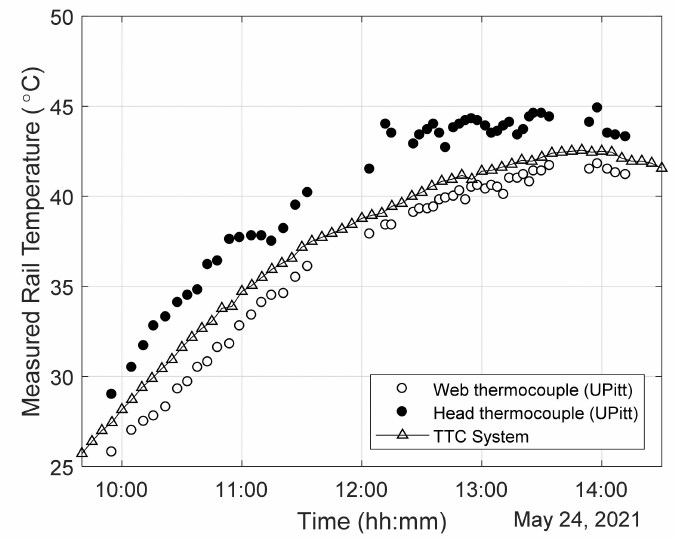
Figure 9. Temperatures of the track taken with three independent units. The lack of data between 11:30 AM and Noon was related to some setting adjustments not related with the content of this